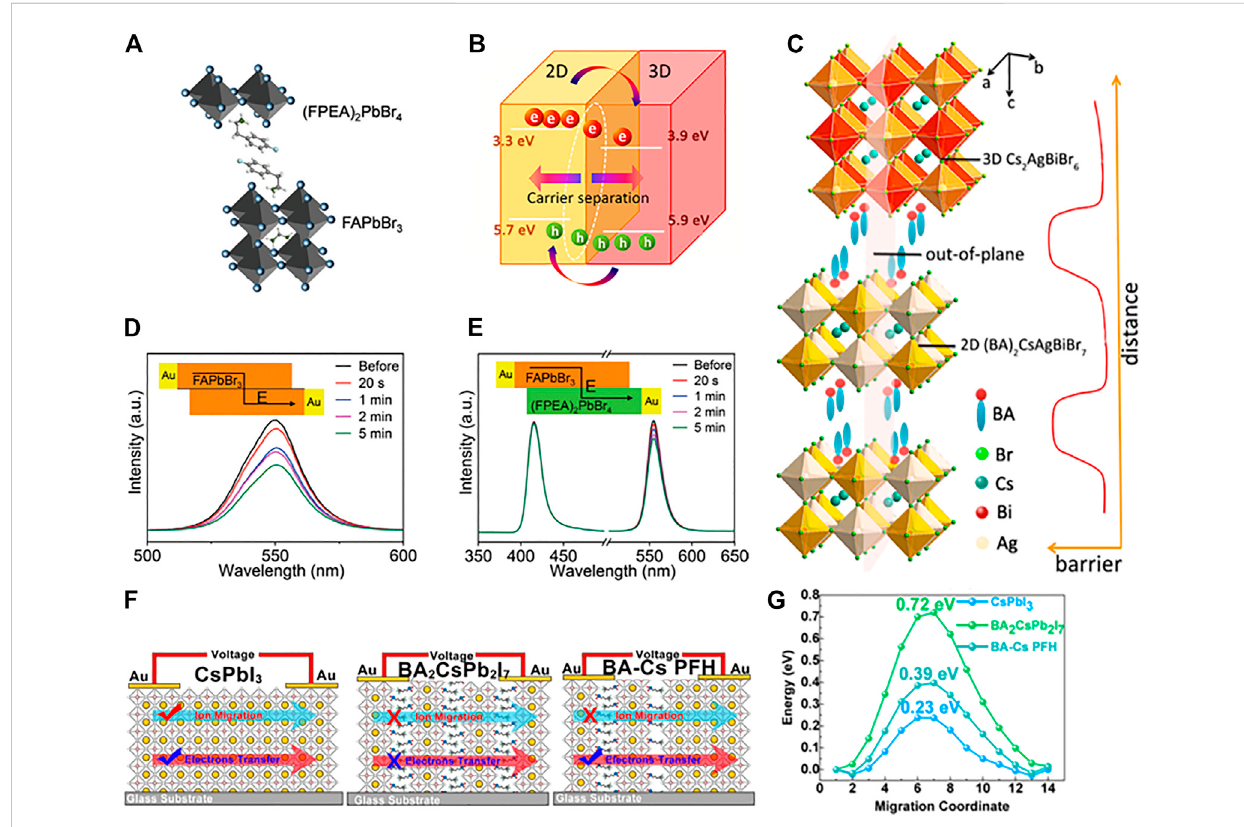
FIGURE 2 (A) The Schematic diagram of (FPEA) 2 PbBr 4 /FAPbBr 3 heterojunction. (B) Band alignment and (C) schematic diagramof (BA) 2 CsAgBiBr 7 /Cs 2 AgBiBr 6 heterocrystals. (D) (E) Photoluminescence (PL) spectra intensity of 3D FAPbBr 3 /3D FAPbBr 3 and 3D FAPbBr 3 /2D (FPEA) 2 PbBr 4 fi lm. (F)